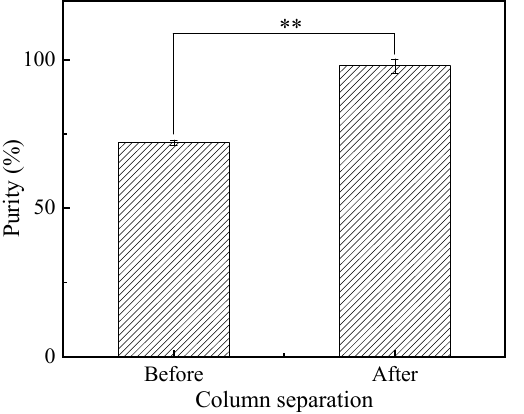
Figure 6. The purity of EPA-EE detected with GC in distillates after treatment with column separation. The asterisks (**) indicate the significant differences between the two groups at p < 0.01.